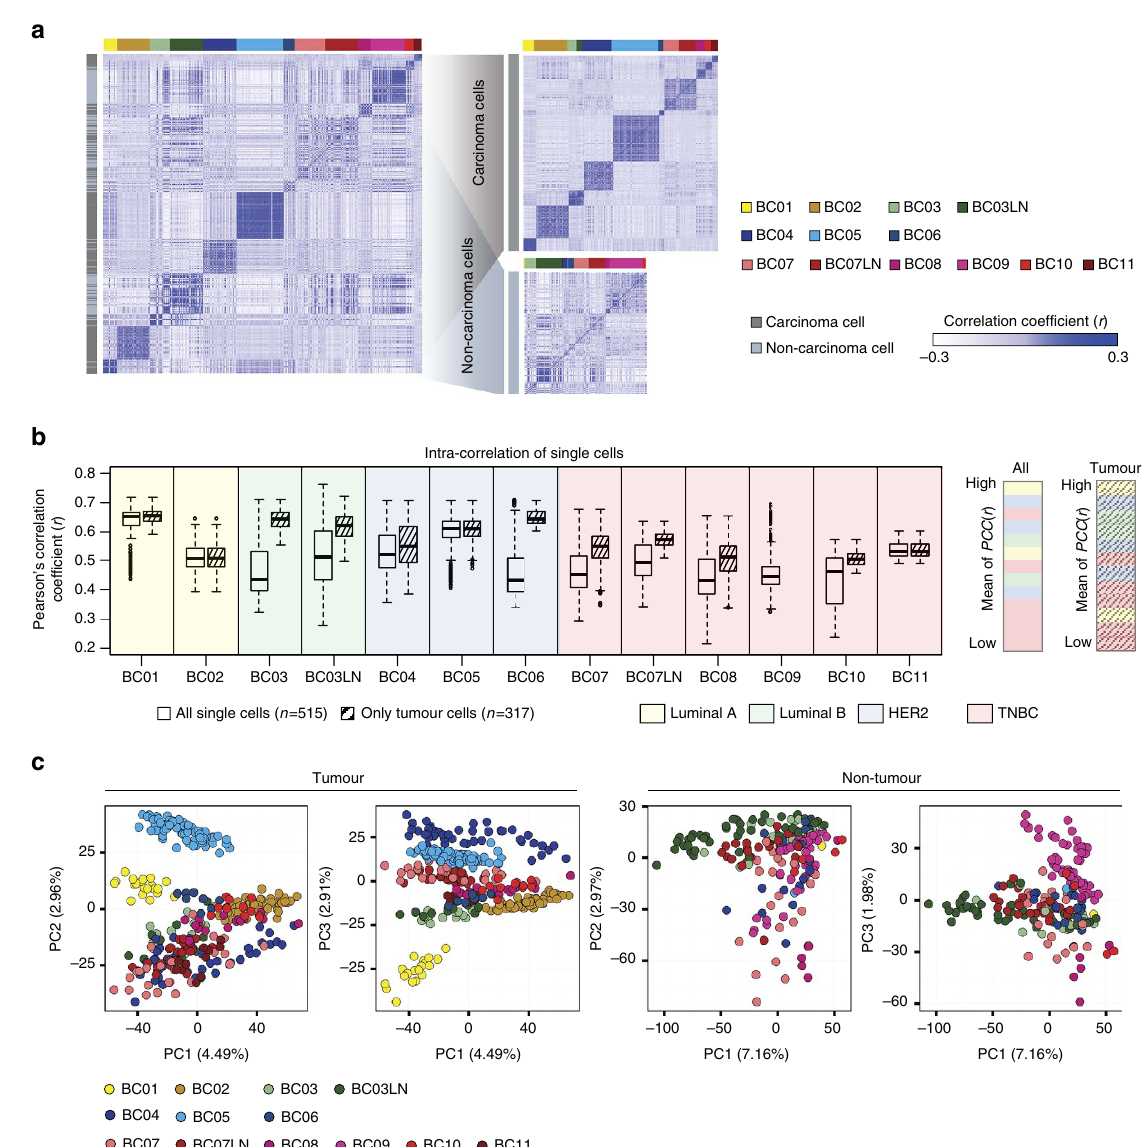
Figure 3 | Removal of non-carcinoma cells reveals intrinsic tumour cell heterogeneity. ( a ) Centred correlation matrix for all single cells demonstrates low cell-to-cell correlations (Pearson’s r ) in tumours with lymph node metastases (left). After separation of carcinoma and non-carcinoma cells, cell-to-cell correlations within the same tumour group are increased (right). Each row and column represents single cells. In the colour panel on the far left side, grey represents tumour and light blue represents non-tumour cells. ( b ) Intratumoral correlations before (white boxes) and after (striped boxes) the removal of non-carcinoma cells (left). Each box shows the median and interquartile range (IQR 25th–75th percentiles), whiskers indicate the highest and lowest value within 1.5 times the IQR and outliers are marked as dots. Samples were ranked by mean value of cell-to-cell Pearson’s correlation coefficient (right). ( c ) Unsupervised PCA on the transcriptome separating patient-specific tumour groups for only tumour